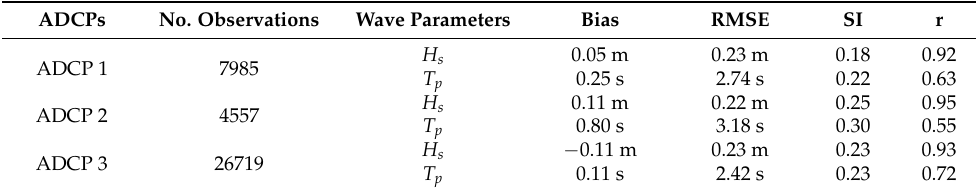
Table 1. Comparison of modeled and observed wave characteristics at three different locations within BTS. ADCPs No. Observations